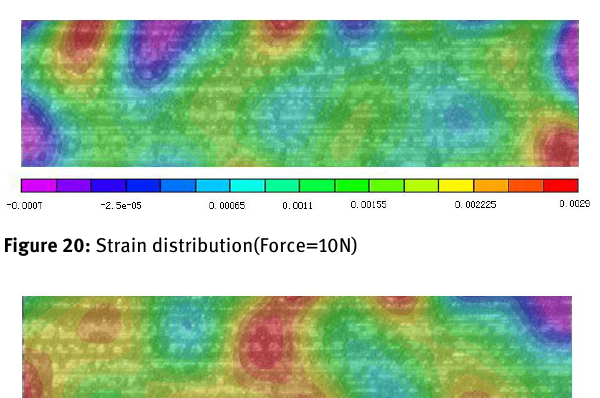
Figure 19: Strain distribution(Force=5N)